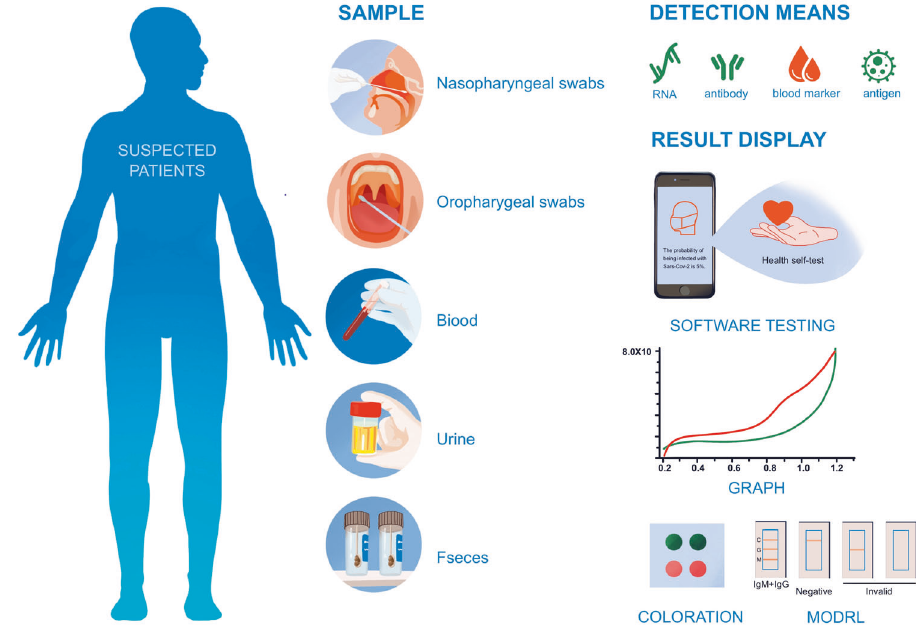
Fig. 1 Laboratory diagnostic method of